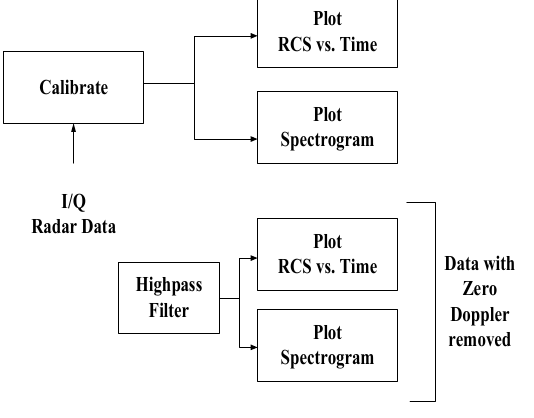
Figure 11. Calibration and scattering processing [64].